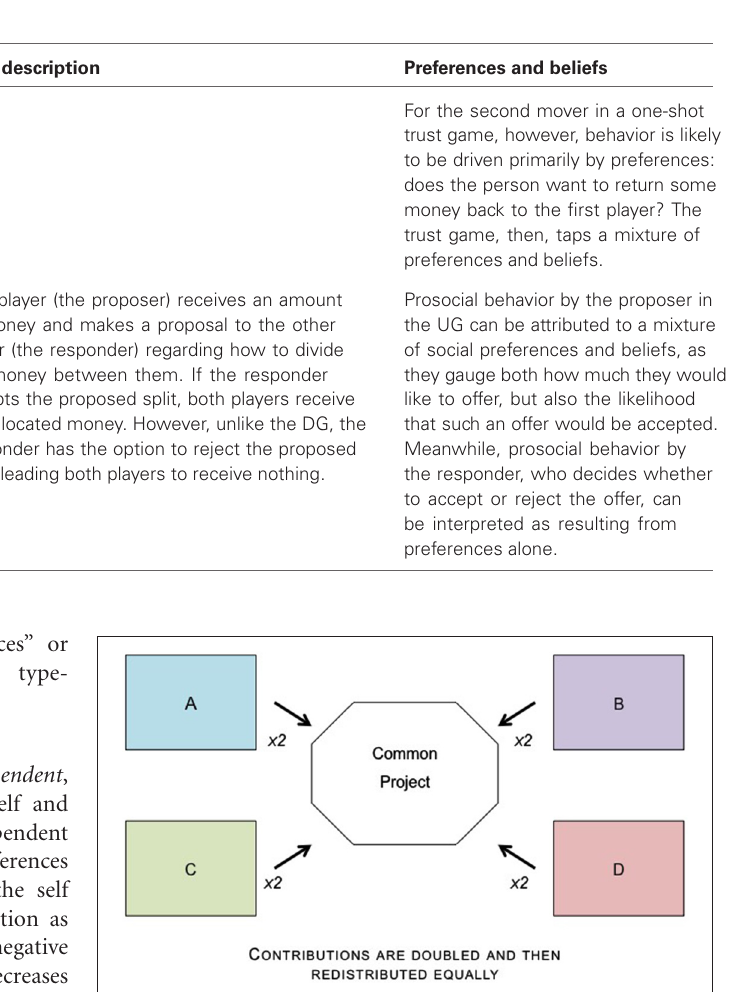
FIGURE 1 | Public Goods Dilemmas require participants to choose how many points to contribute to a common project. The points that are contributed are then doubled and then redistributed equally to each player.